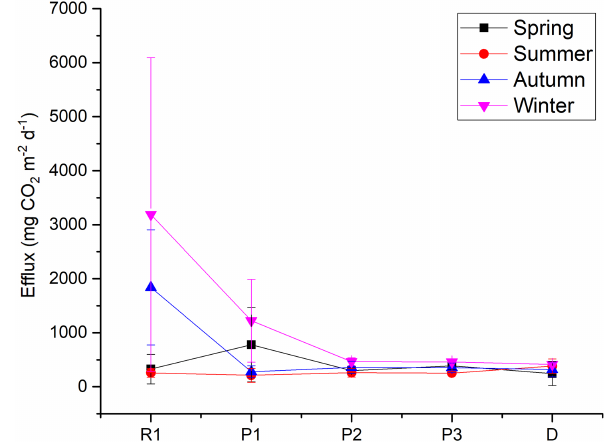
Figure 5. Longitudinal variation in effluxes along the main stem in different seasons. The points and error bars refer to mean values and standard deviations,